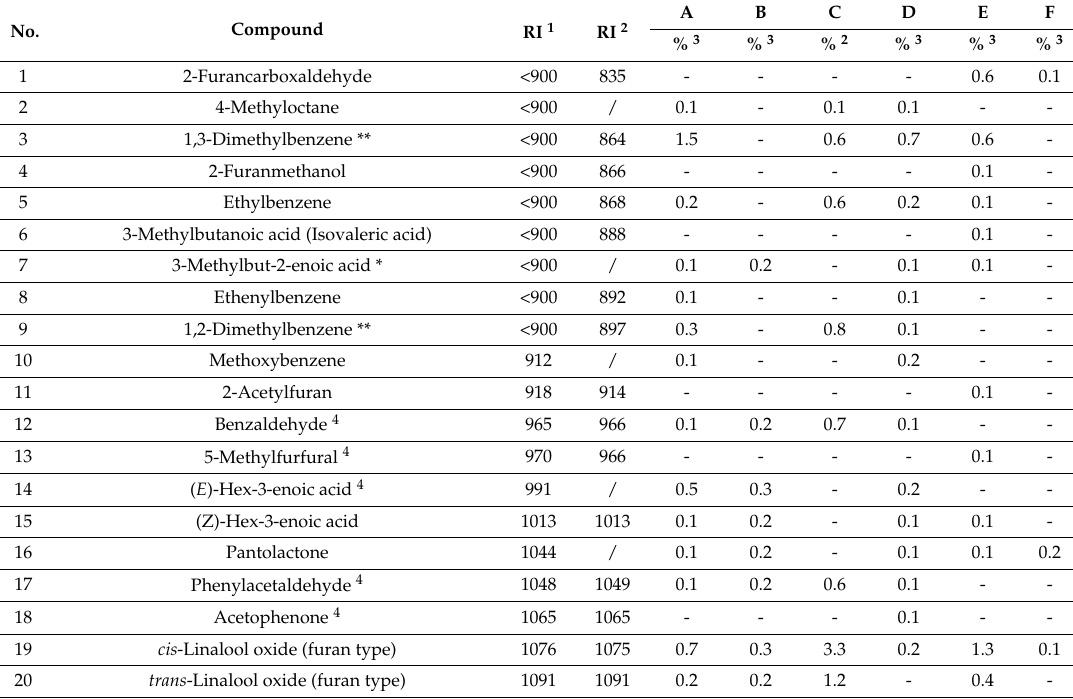
Table 2. The volatile organic compounds composition of the sample determined by ultrasonic solvent extraction (USE)/GC-FID;